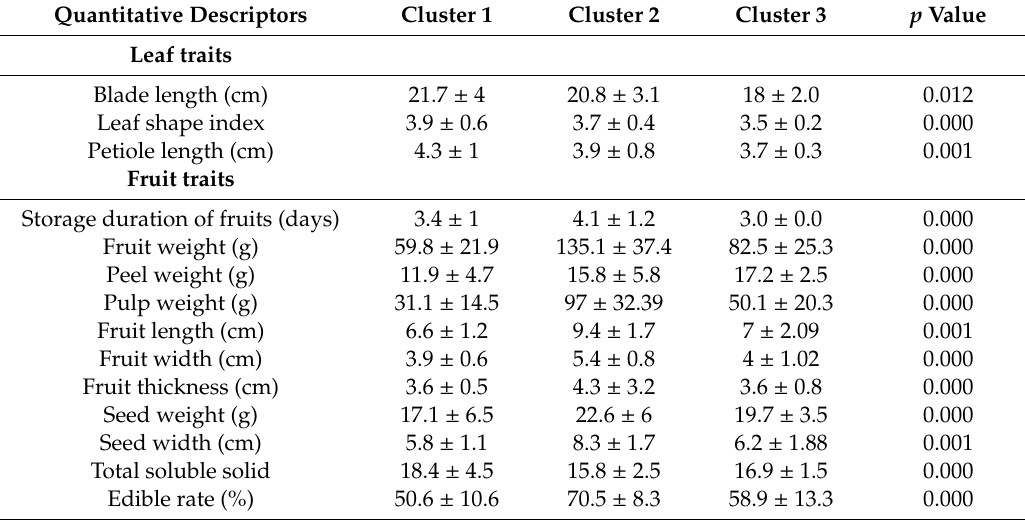
Table 4. Characteristics of clusters based on discriminant quantitative